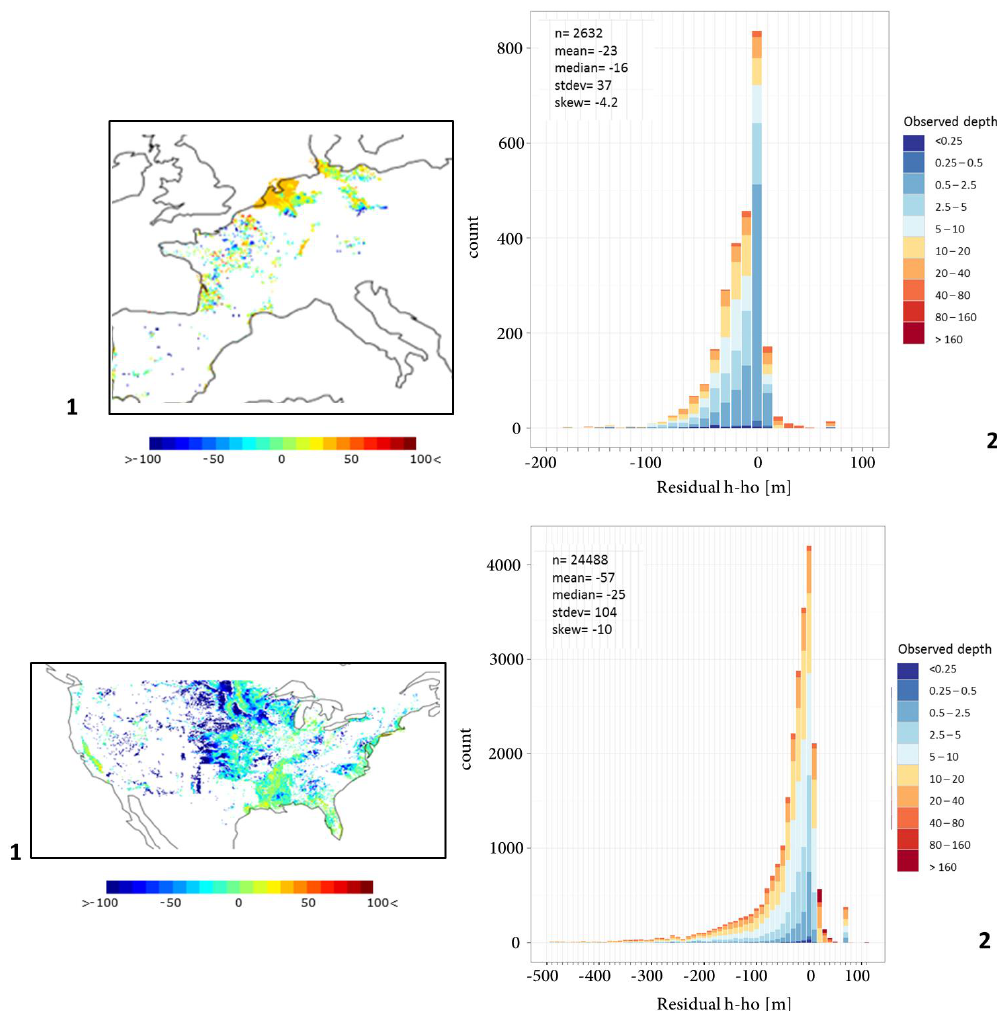
Figure 7. Maps of residuals for NW Europe and USA. (1) Residuals and (2) histograms of residuals. Each bar in the histogram is clustered based on observed on classified groundwater